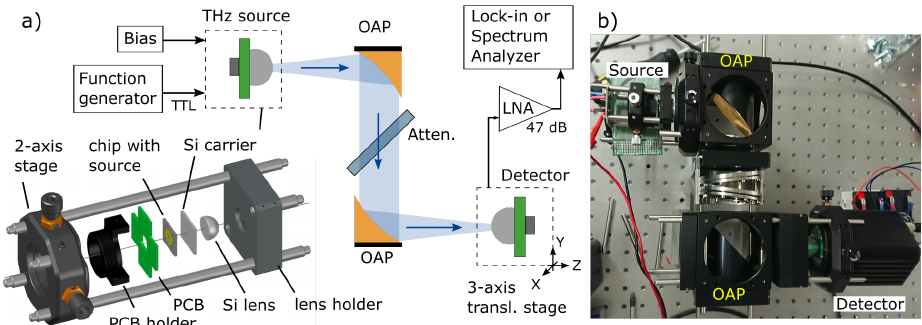
Figure 7. ( a ) Experimental setup for the characterization of the source. Bottom left: the drawing of the source module as used in all experiments. The dashed line represents the setup’s optical axis with the THz beam emitted by the THz source and propagating from the left through the substrate lens to free-space. The chip is not to scale. ( b ) The photo of the characterization system. OAP, off-axis parabolic mirror; PCB, printed circuit board; LNA, low-noise amplifier; Attn., attenuator.